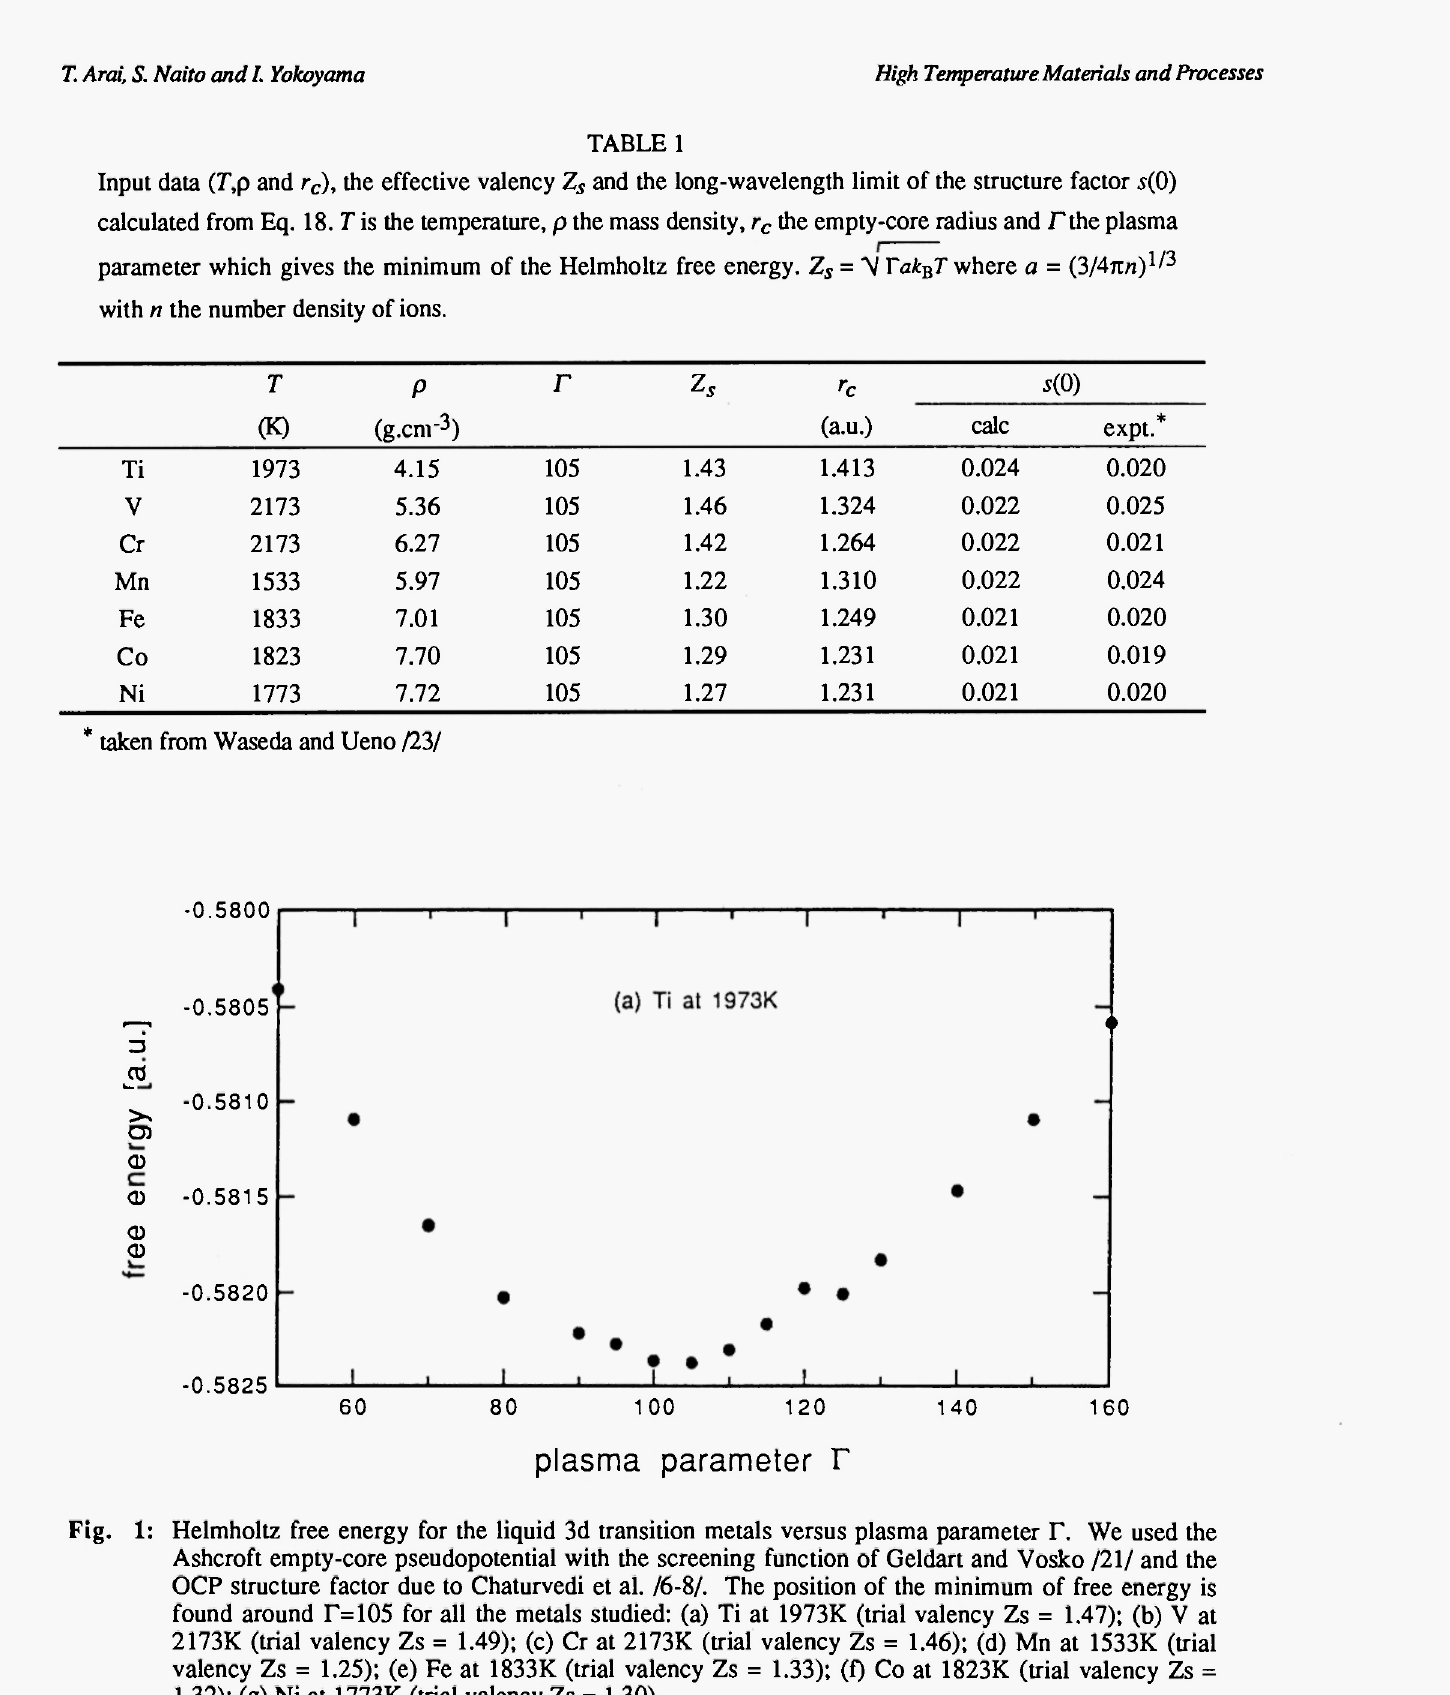
1: Helmholtz free energy for the liquid 3d transition metals versus plasma parameter Γ. We used the Ashcroft empty-core pseudopotential with the screening function of Geldart and Vosko /21/ and the OCP structure factor due to Chaturvedi et al. /6-8/. The position of the minimum of free energy is found around Γ=105 for all the metals studied: (a) Ti at 1973K (trial valency Zs = 1.47); (b) V at 2173K (trial valency Zs = 1.49); (c) Cr at 2173K (trial valency Zs = 1.46); (d) Mn at 1533K (trial valency Zs = 1.25); (e) Fe at 1833K (trial valency Zs = 1.33); (0 Co at 1823K (trial valency Zs = 1.32); (g) Ni at 1773K (trial valency Zs =